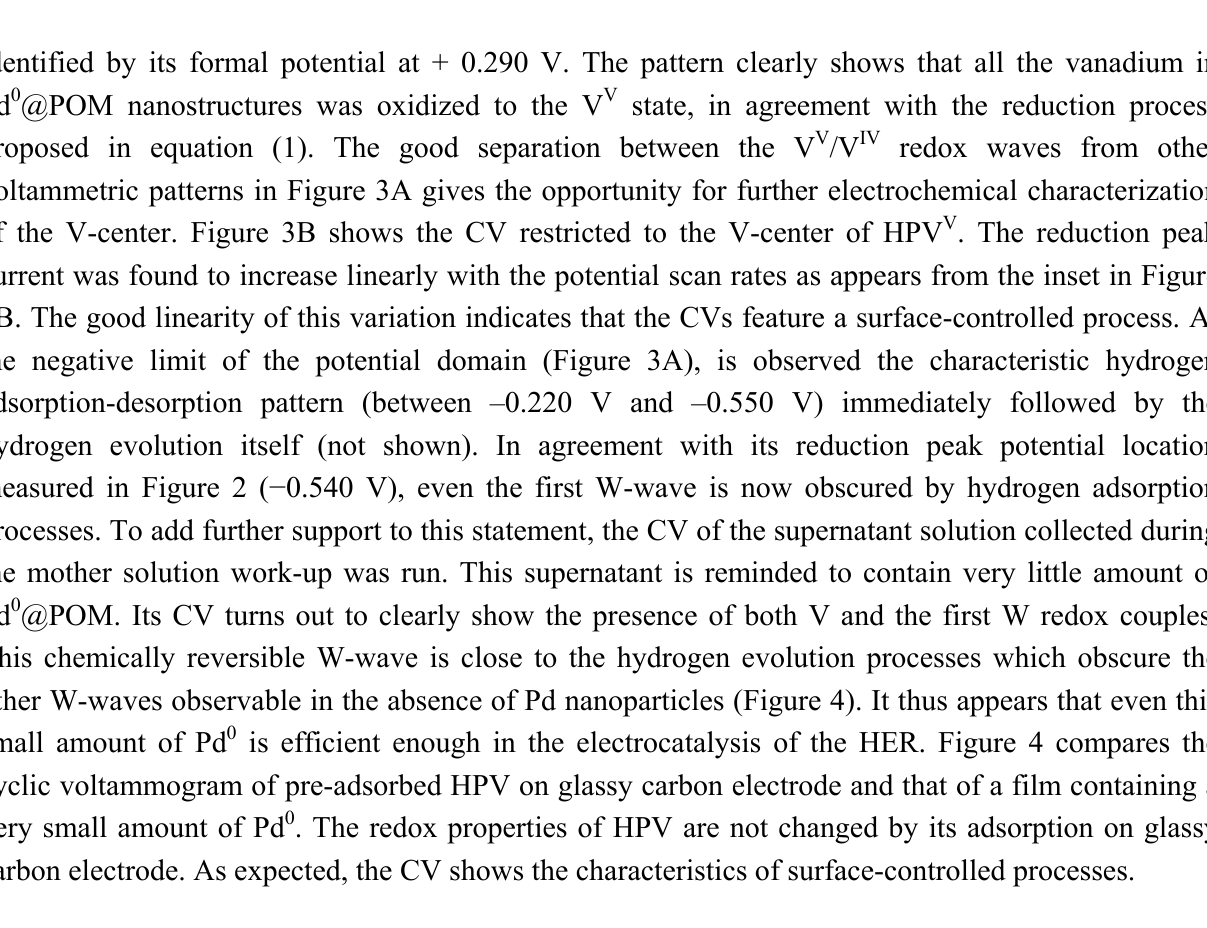
Figure 3. Cyclic voltammograms run in a pH = 5 medium with a Pd 0 @POM glassy carbon-modified electrode. The reference electrode was